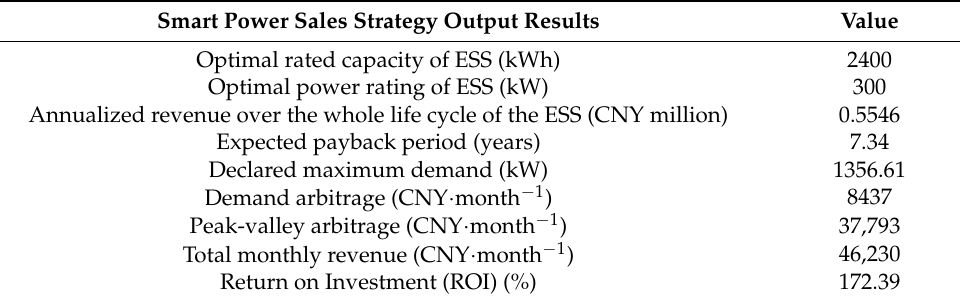
Table 4. Optimization results of smart power selling strategy.